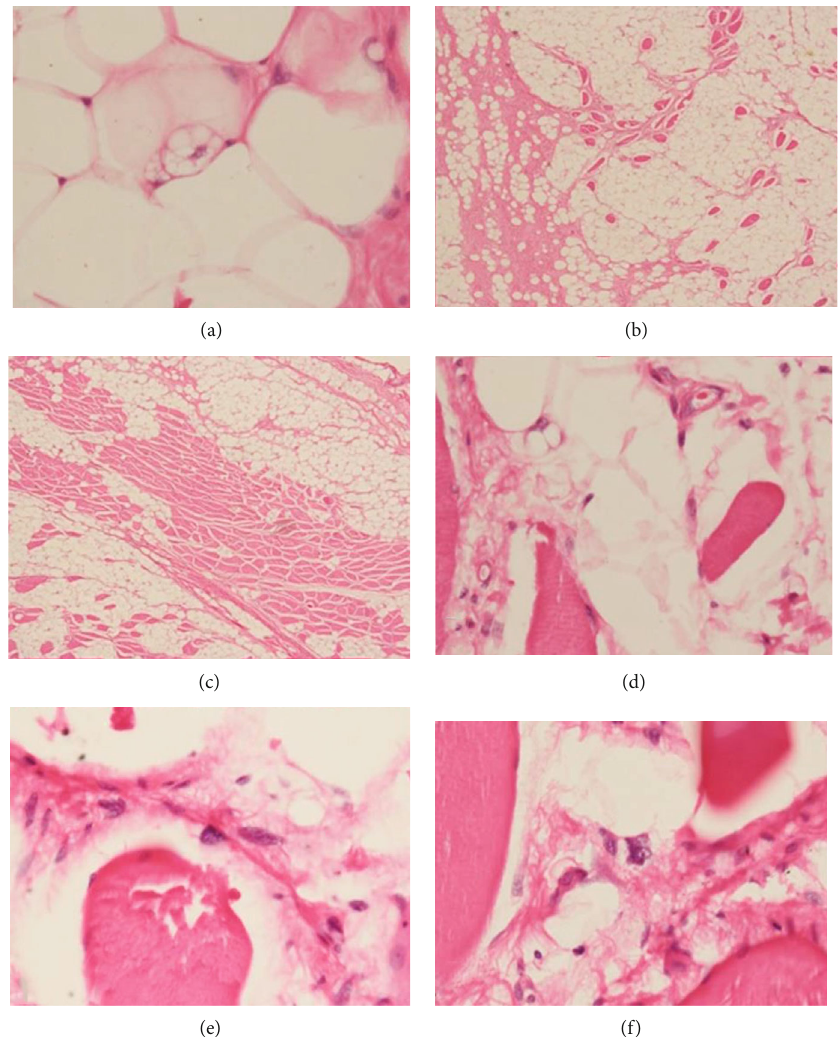
Figure 5: Microscopic examination. (a) Histological revealed characteristic multivacuolated lipoblasts. (b, c) An in fi ltrative, intramuscular component is composed of adipocytic lesion encasing skeletal muscle fi bers. (d – f) Multivacuolated lipoblast and hyperchromatic stromal cells found in between the muscle fi